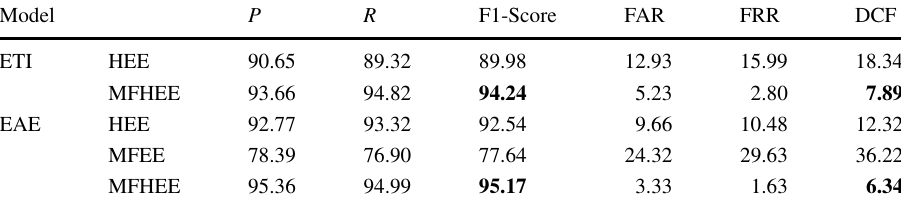
Table 6 Ablation studies results